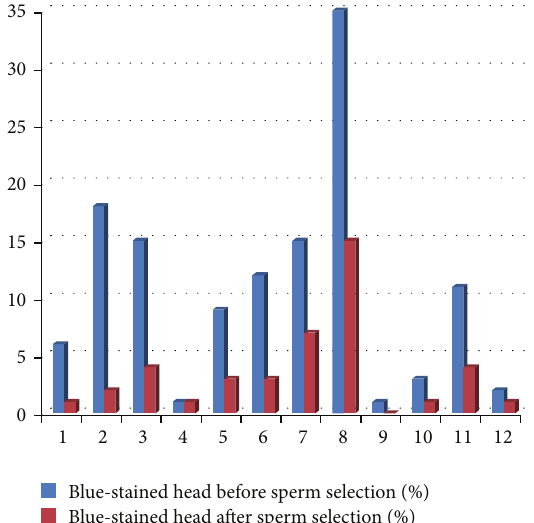
Figure 6: Nuclear maturity before and after sperm selection ( 𝑛 = 12